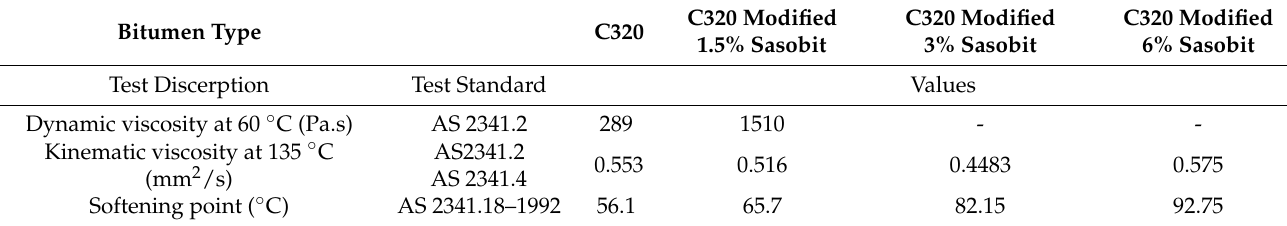
Table 3. Asphalt binder